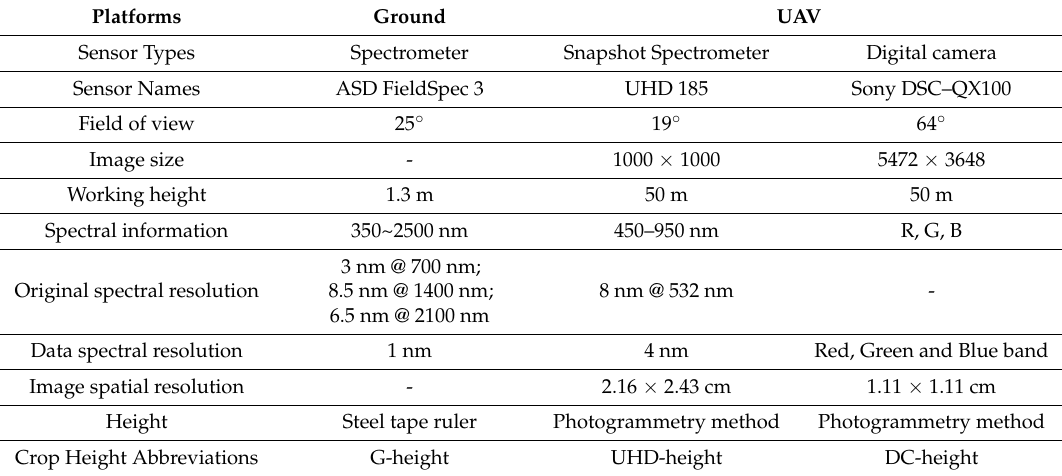
Table 1. Sensor parameters and abbreviations used in this